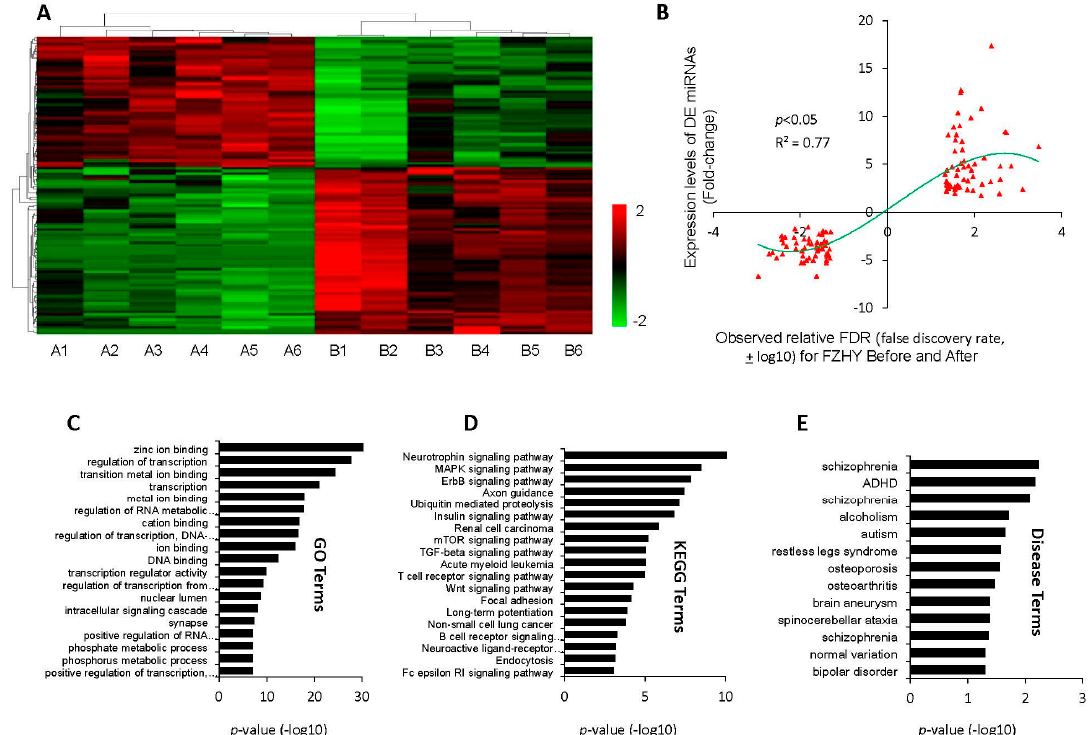
Figure 2. The bioinformatics analysis of miRNAs and target genes between before and after FZHY treatment for hepatitis B-caused cirrhosis (HBC) patients. ( A ) Heat-map of the differential expression of miRNAs between before and after FZHY treatment. Red color represents that the miRNA is upregulated, and green color represents downregulated. The relationship among the samples was divided by binary tree classification and is shown in the upper portion. The hierarchical cluster of miRNAs is displayed at the bottom; ( B ) The distribution of differential expressed (DE) miRNA expression levels; the right side represents the up-expressed miRNAs between before and after FZHY treatment; the left side represents the down-expressed miRNAs between before and after FZHY treatment; ( C – E ) MiRNA target genes related Gene ontology (GO) terms, Kyoto Encyclopedia of Genes and Genomes (KEGG) terms and disease terms.